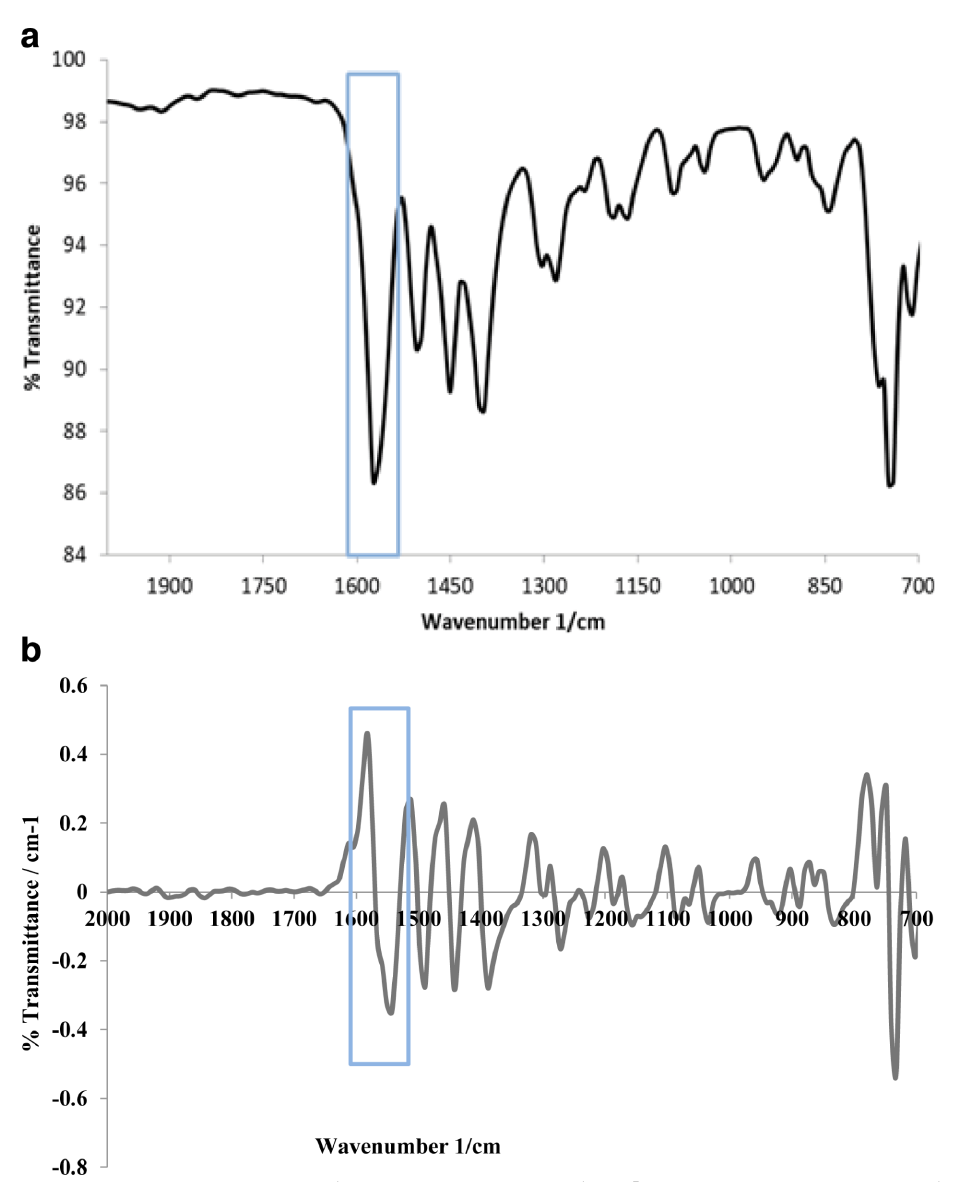
Figure 2. ( a ) Spectrum of pure diclofenac sodium mixed with potassium bromide (KBr; 0.6% w/w). ( b ) First derivative spectrum of pure diclofenac sodium mixed with KBr (0.6% w/w).